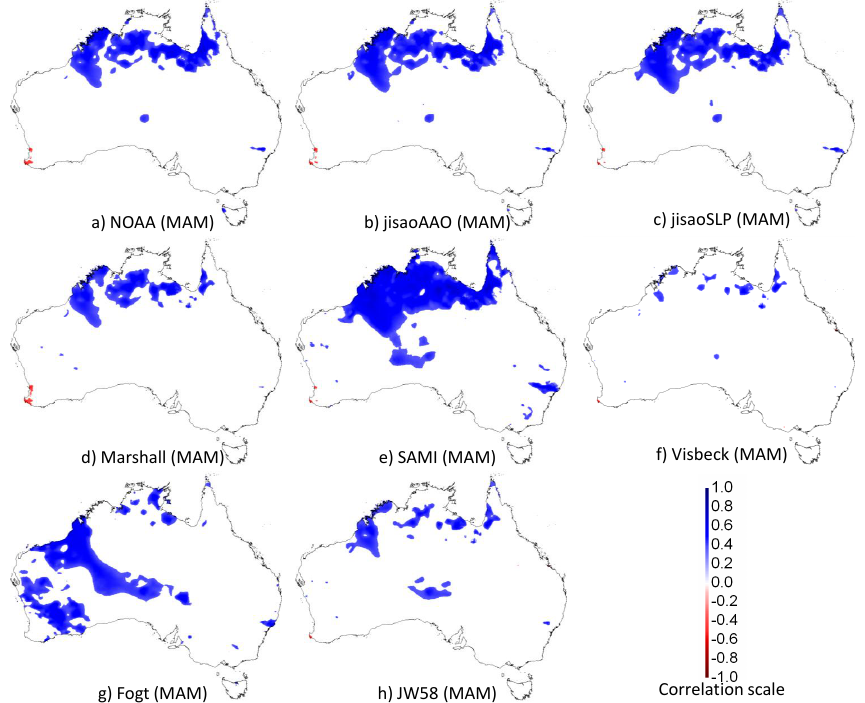
Fig. 5. Correlations between total autumn (MAM) rainfall and autumn SAM indices, 1979–2002 (a) NOAA; (b) jisaoAAO; (c) jisaoSLP; (d) Marshall; (e) SAMI; (f) Visbeck; (g) Fogt and (h) JW58. Note: only correlations that are statistically significant at the 95th percentile are